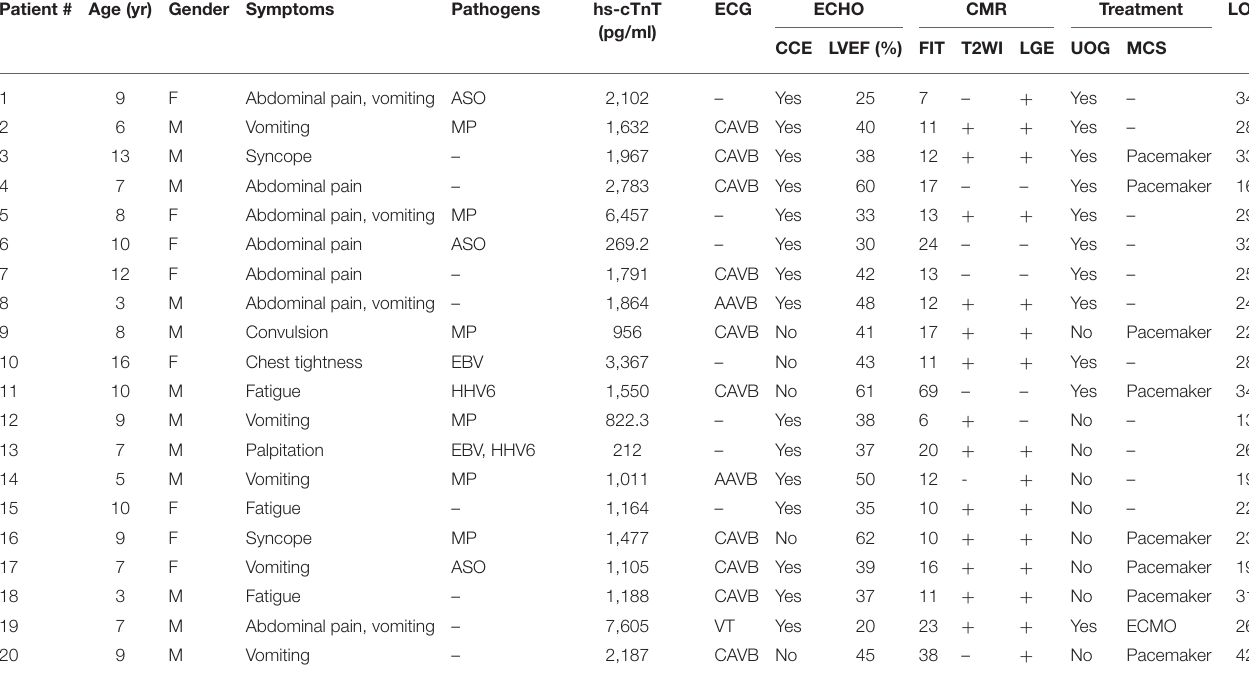
TABLE 1 | Main clinical data of 20 children with